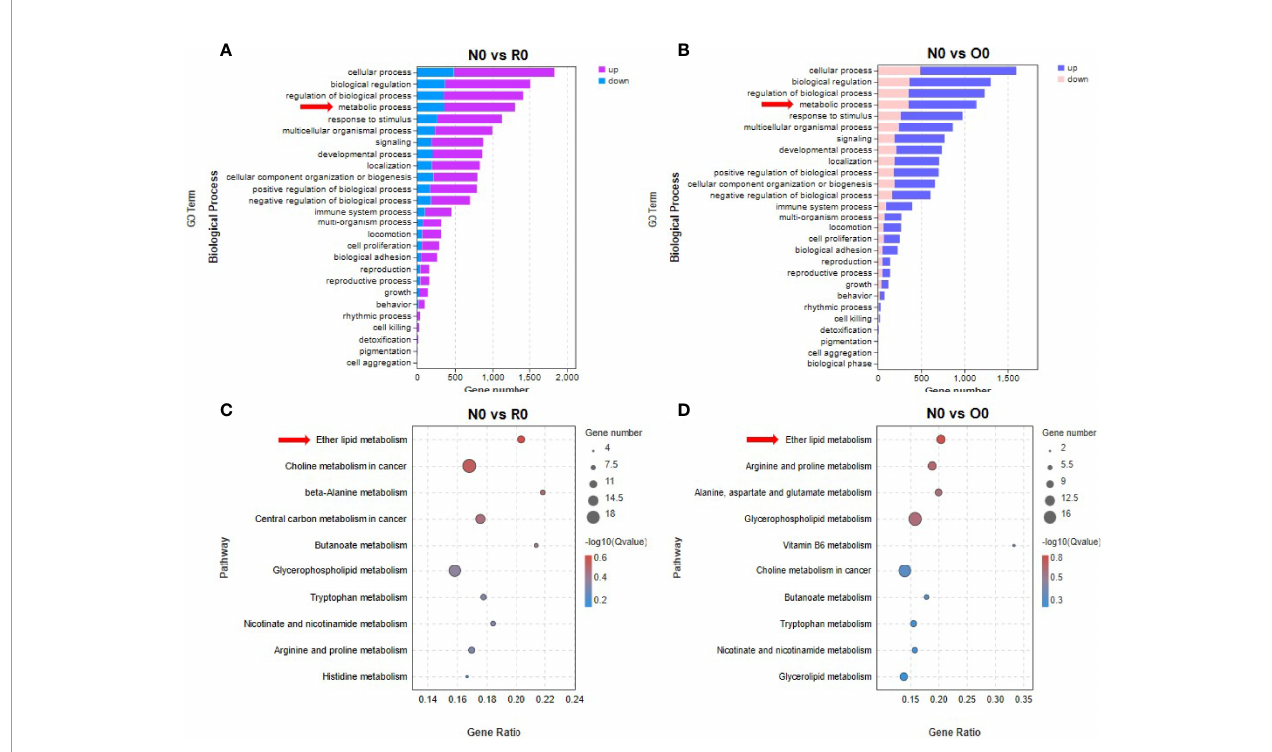
FIGURE 4 | Ether lipid metabolism was associated with the mechanism of HHT resistance. By GO enrichment analysis, several biological processes were found to be signi fi cantly affected in long-term HHT-treated cell lines (A, B) . Signi fi cant effects of HHT on metabolism-related signaling pathways were found by KEGG enrichment analysis (C, D)